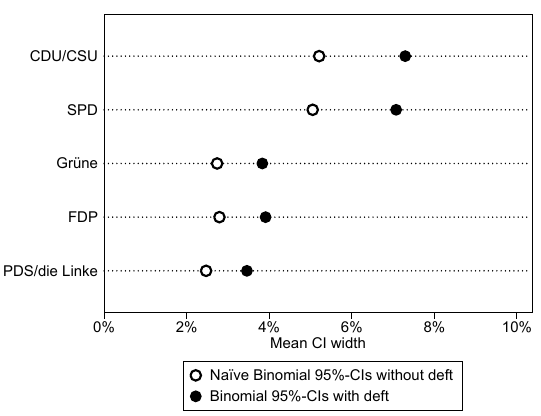
Figure 4 : Dot chart of mean 95%-CI